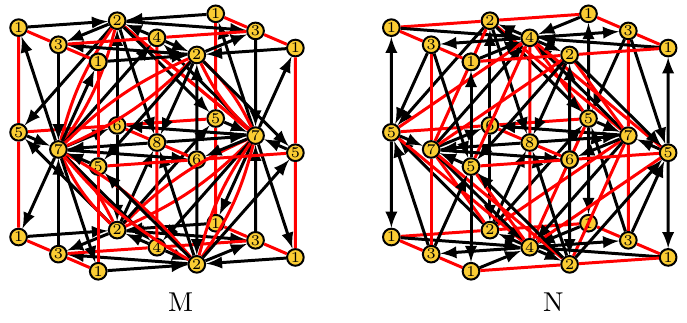
Table 6. Periodic quivers for the 14 toric phases of Q 1 ; 1 ; 1 = Z 2